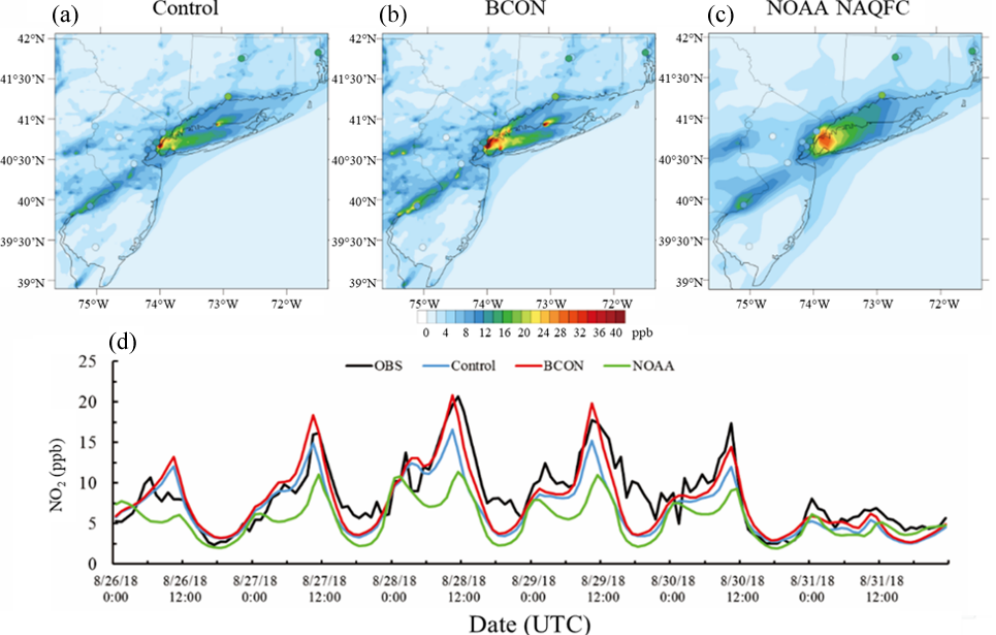
Figure 3. Predicted NO 2 concentrations from (a) Control, (b) BCON and (c) NOAA NAQFC simulations on 29 August 2018 and (d) comparison of domain-averaged hourly NO 2 concentrations to EPA AirNow measurements during the episode. Colored circles in the top panels depict the observed concentrations from ground